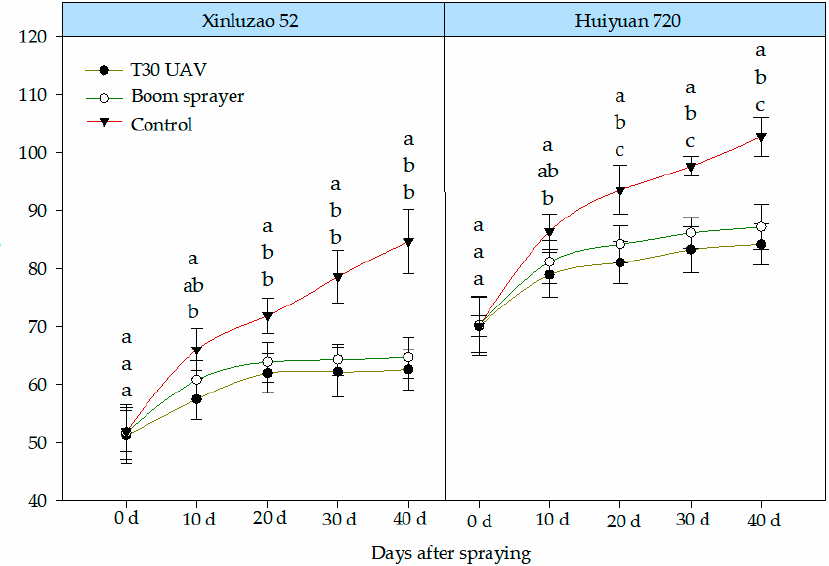
Figure 6. Effects of chemical topping agent sprayed by two sprayers on the cotton plant height. Different lowercase letters indicate significant differences between treatments at the 5% probability level ( p < 0.05).